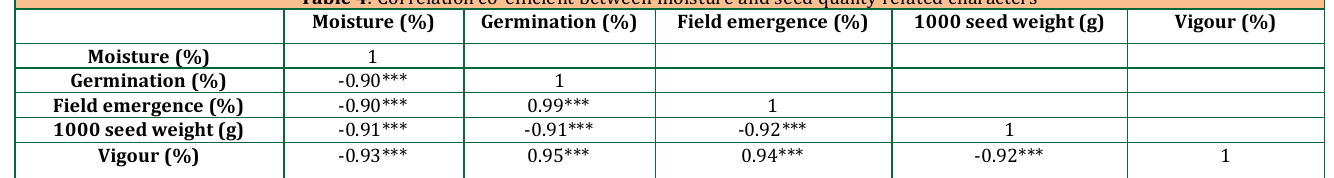
Table 4 : Correlation co-efficient between moisture and seed quality related characters Moisture